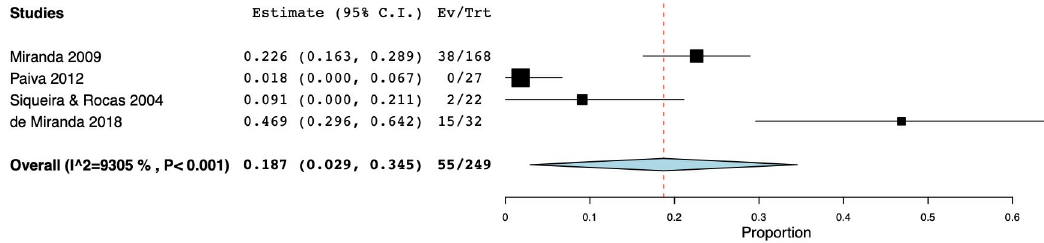
Fig 7. Forest plot representing fungal species prevalence in molecular studies assessing teeth with primary and secondary endodontic infections with periapical lesions.